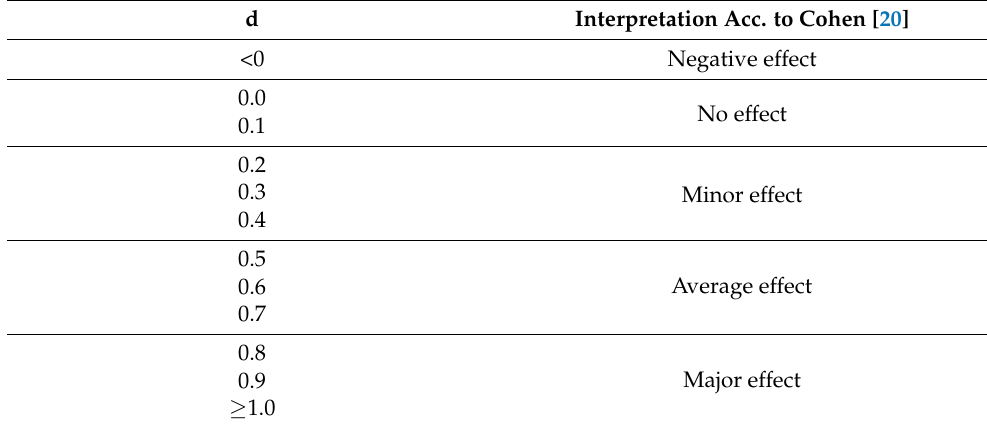
Table A3. Interpretation of effect intensity according to Cohen [20] from Lenhard and Lenhard [30].